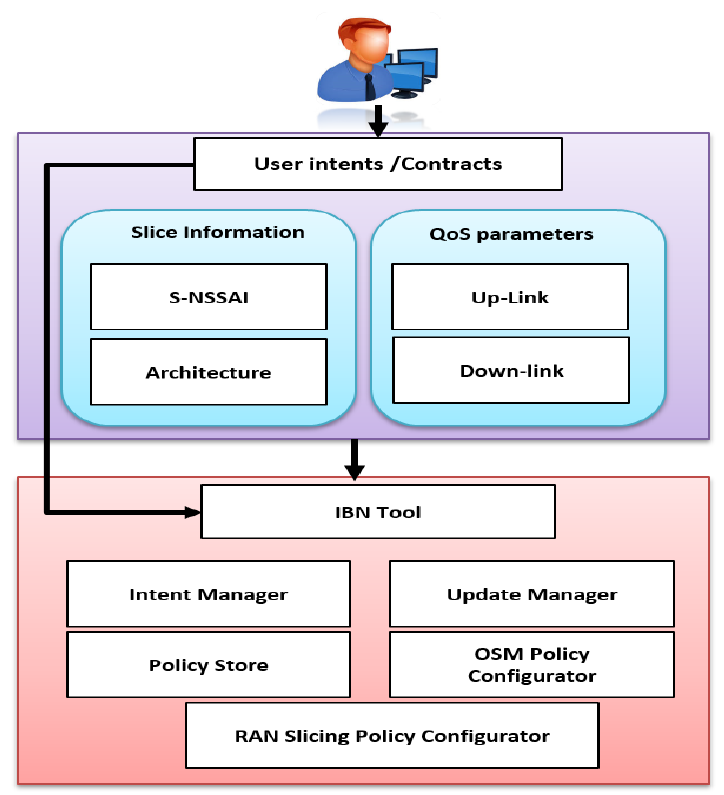
Figure 4. User intents or contracts design with required